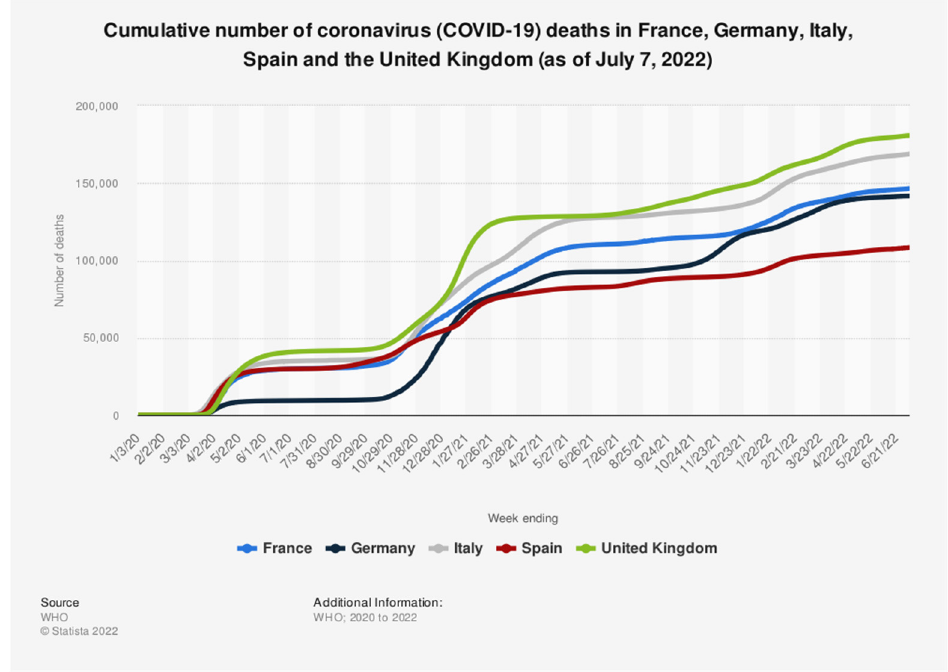
Figure 11. COVID-19 deaths in 5 European Countries (Statista 2022a).